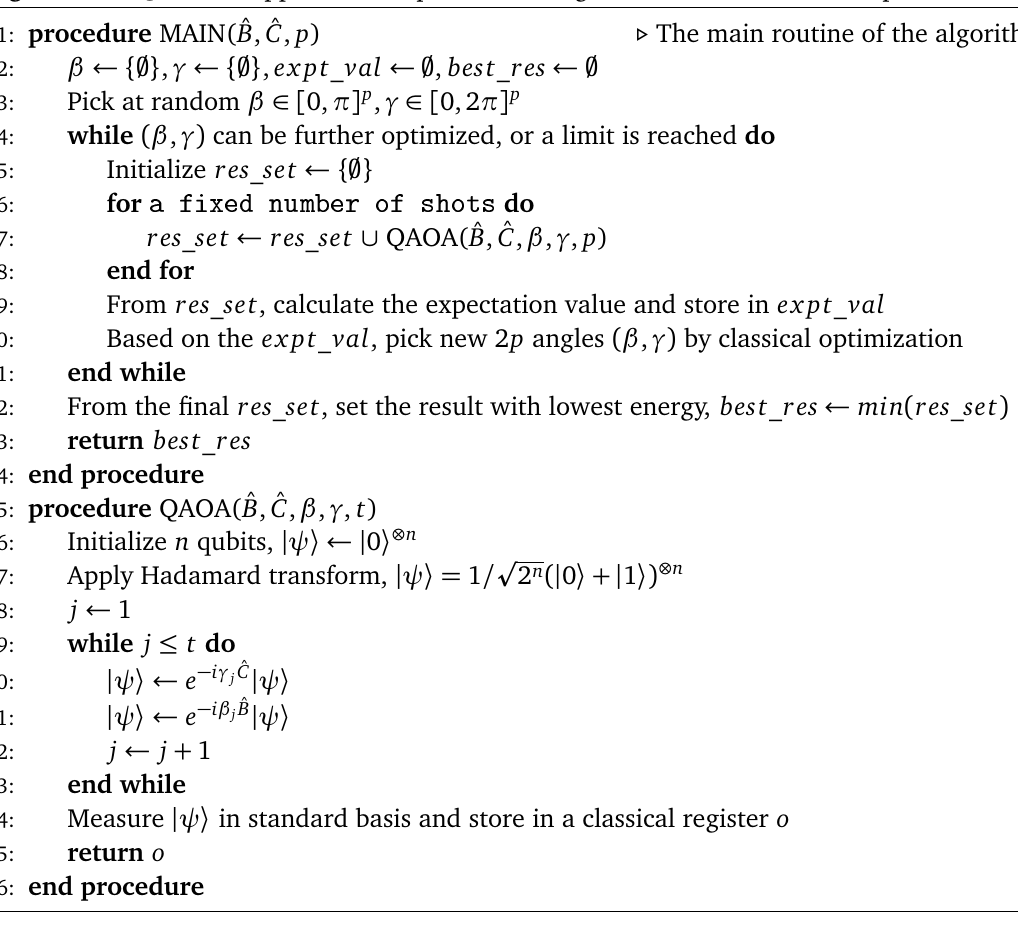
Algorithm 2 Quantum approximate optimization algorithm for minimization